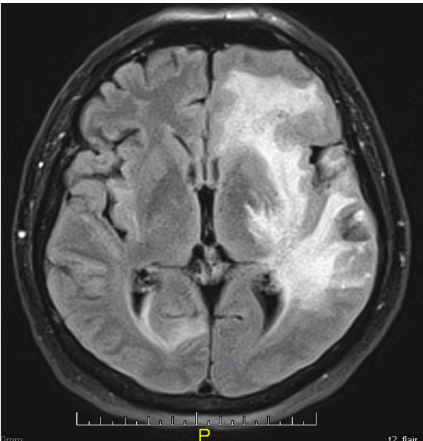
Figure 1: Brain RMI revealed a suggestive image of brain mass at the left parietal lobe, with bilateral bleeding areas predominantly in the left brain.